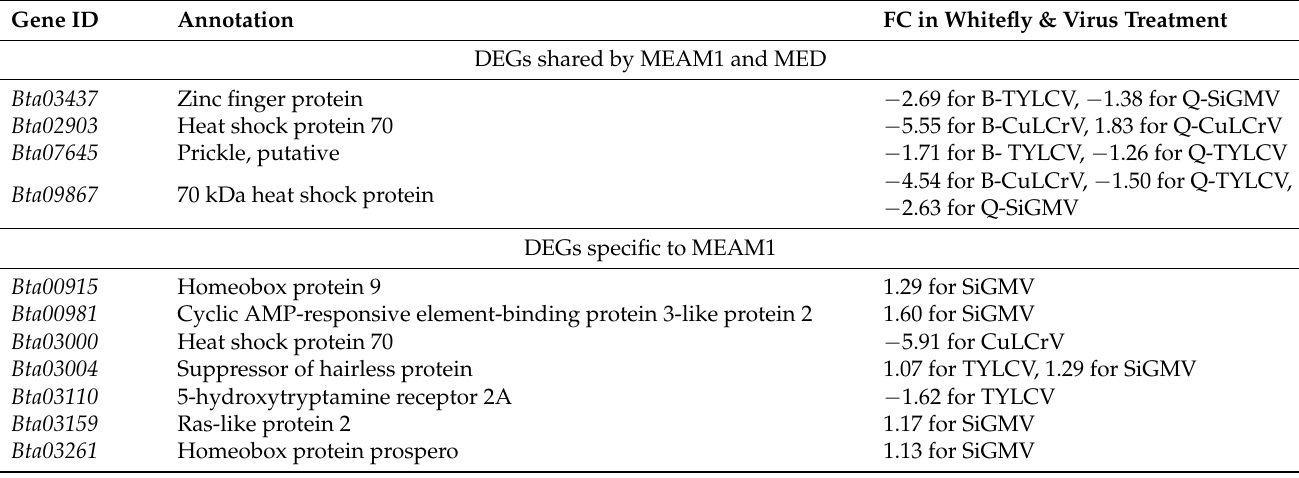
Table 3. Differential expression of genes associated with signal transduction in viruliferous compared with non-viruliferous Bemisia tabaci Middle East-Asia Minor 1 and Mediterranean (MED)